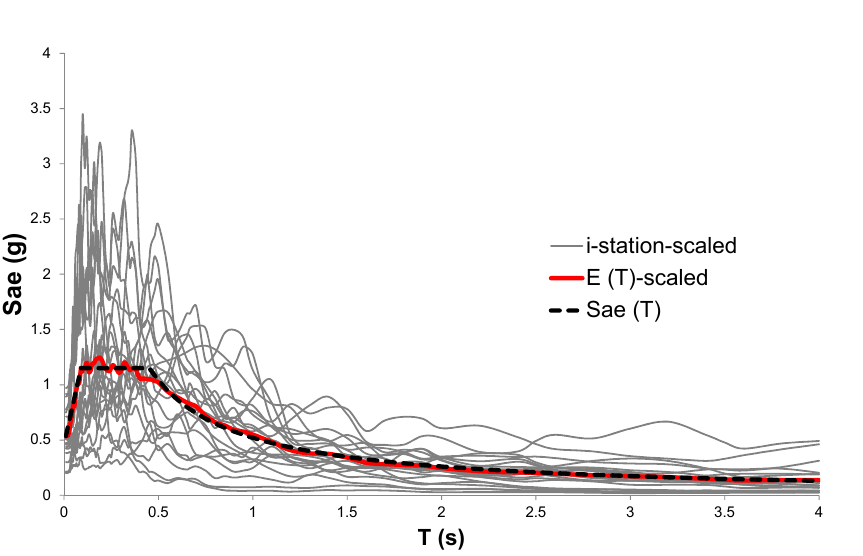
Figure 6. The square root of the sum of the squares (SRSS) spectrum of scaled acceleration records.